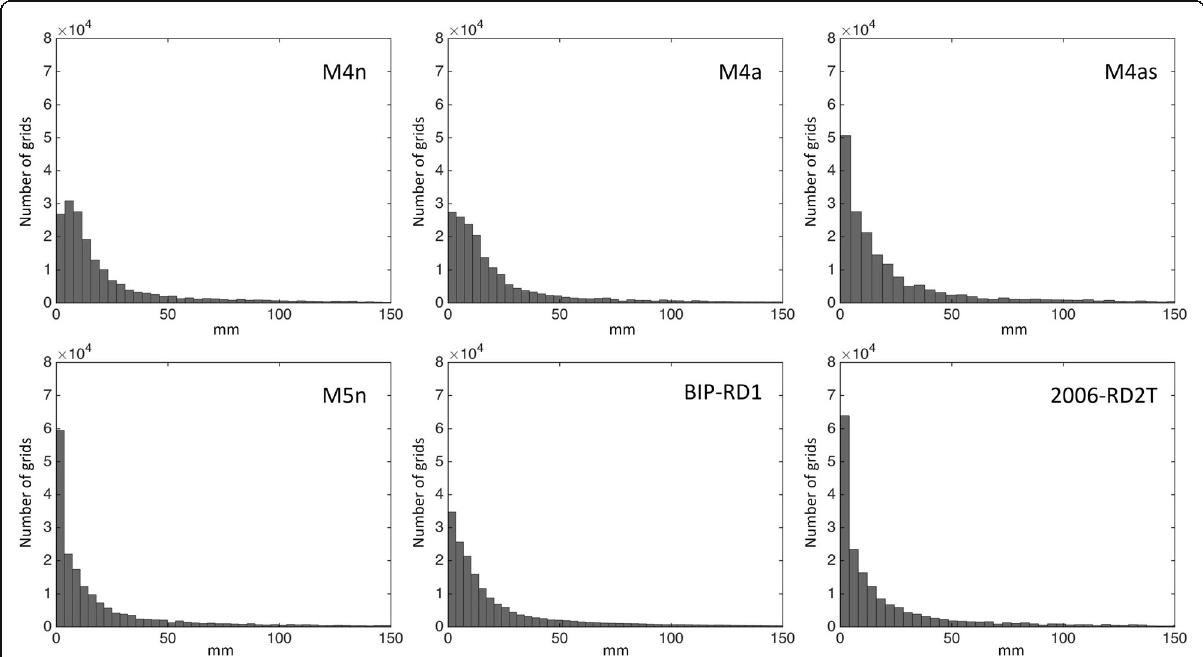
Fig. 7 Histogram plot of JJA rainfall (mm) in